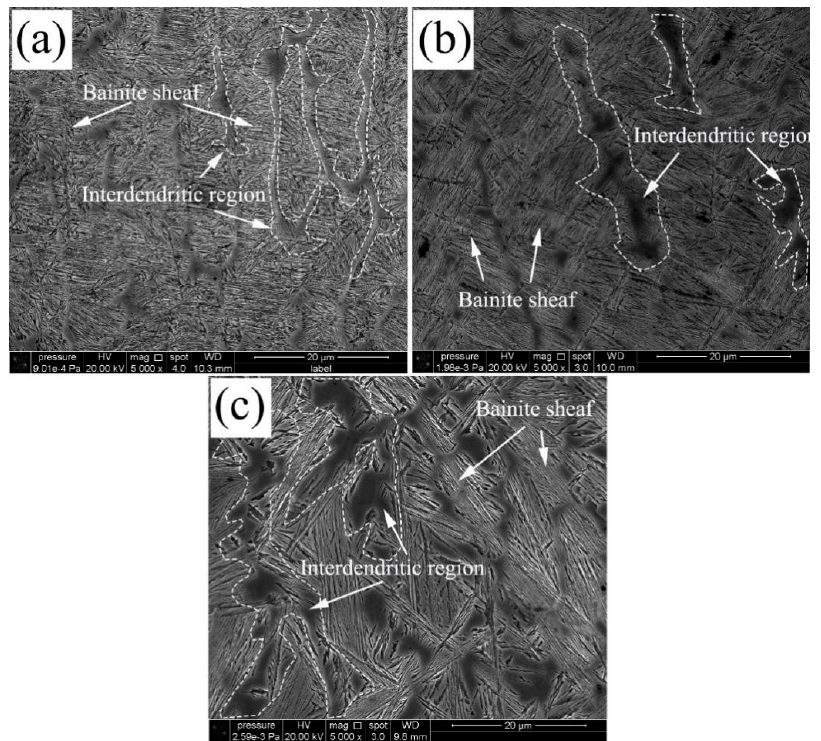
Figure 4. SEM morphologies of microstructure: ( a ) 200 °C transformed for 24 h, ( b ) 250 °C transformed for 16 h, ( c ) 300 °C transformed for 8 h.